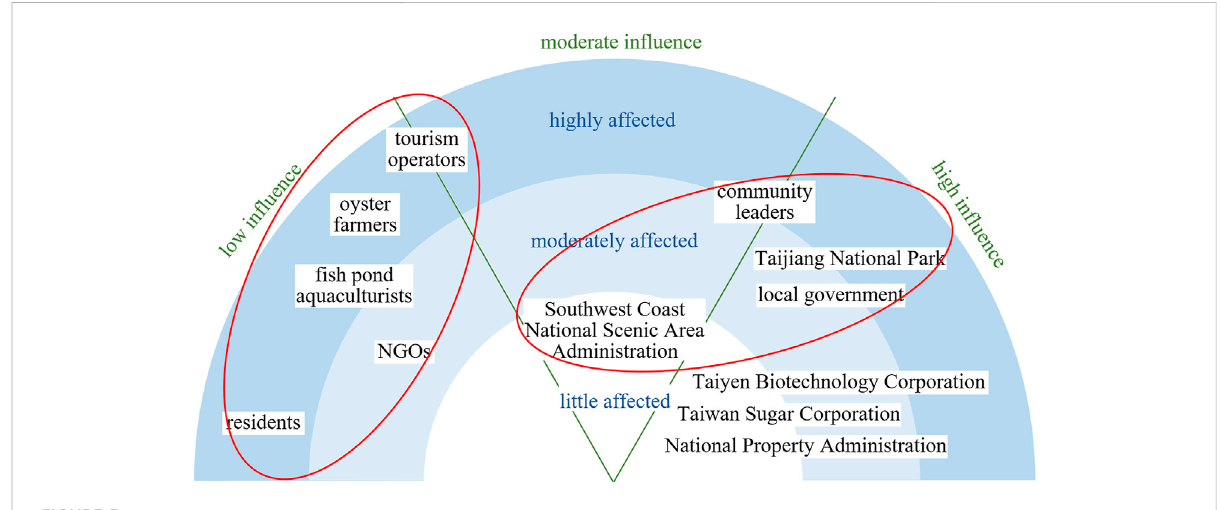
FIGURE 5 Stakeholder rainbow diagram for Cigu ’ s socioeconomic